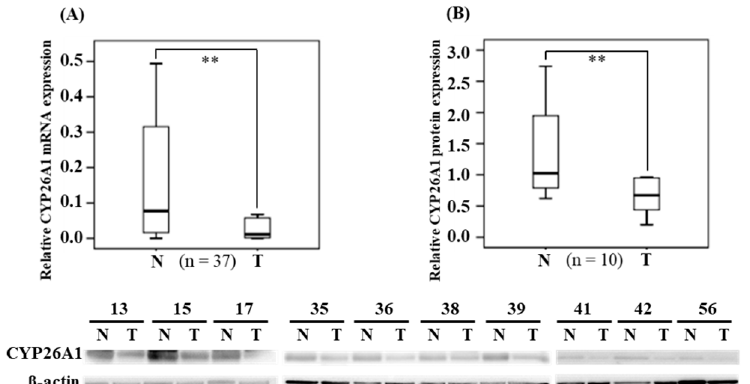
Figure 1. Expression of CYP26A1 in human oral and pharyngeal cancer tissues. ( A ). The relative mRNA (2 −ΔΔ Ct ) expression of CYP26A1 (n = 34) in human oral and pharyngeal tumor (T) tissues compared with their adjacent normal (N) tissues. ( B ). In human oral and pharynx tumor (T) tissues compared with their adjacent normal (N) tissues (representative cases are shown with β -actin as the protein loading control), the protein levels were examined by Western blotting and quantitated using Image J (n =10). The results are represented as the median (IQR). The boxes denote the interquartile ranges, while the bars represent the highest and lowest values, excluding outliers and extreme outliers. ** p < 0.01 compared to the normal group.